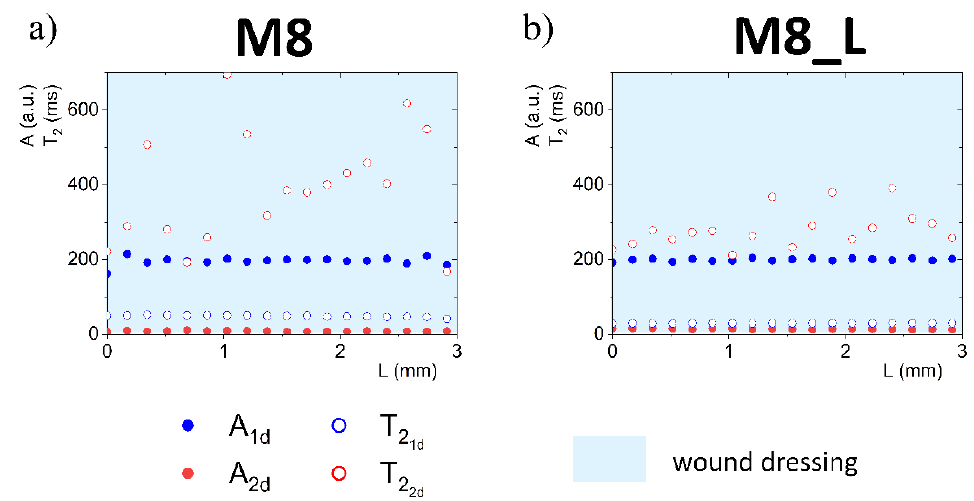
Figure 3. 1D parametric profiles in terms of T 2 relaxation time and signal amplitude ( A ) across the wound dressing before application on sponge substrate, for M8 ( a ) and M8_L ( b ) samples. Table 1. Average values of the A and T 2 parameters as measured across the hydrogel wound dress- ing.